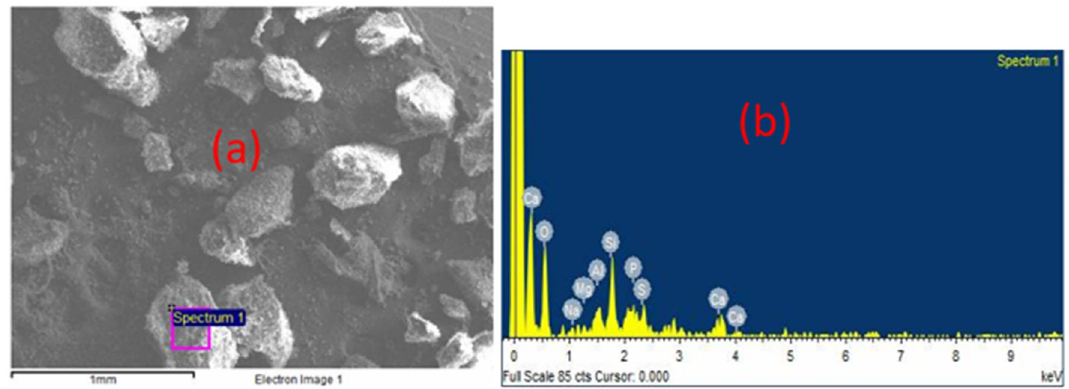
Figure 4. Elemental EDS analysis of raw sewage sludge S: ( a ) and ( b ).